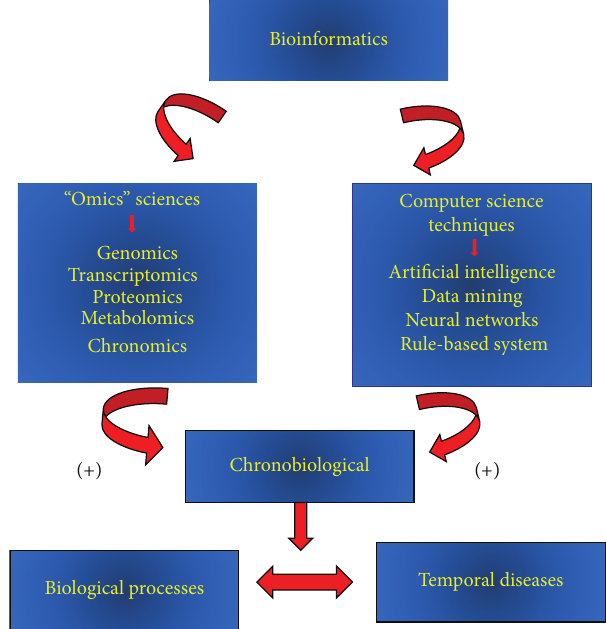
Figure 1: Relationship between bioinformatics, chronobiological, and